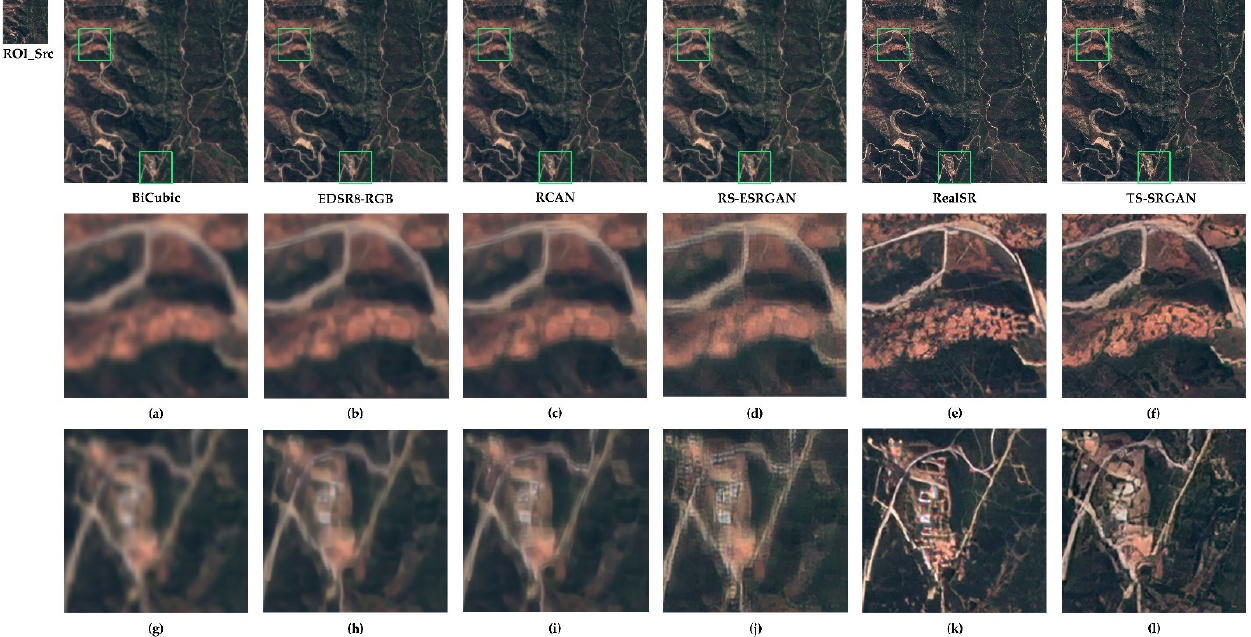
Figure 14. Comparison of visual effects of the generated images of the region containing mountain- road terrain. NR-IQA of images (NIQE, BRISQUE, PIQE): BiCubic (6.28, 54.73, 91.87), EDSR8-RGB (5.85, 50.25, 86.05), RCAN (4.64, 47.69, 62.20), RS-ESRGAN (3.31, 22.16, 8.42), RealSR (3.16, 15.75, 8.52), TS-SRGAN (2.43, 7.36, 7.48). The subfigures ( a – l ) in the figure represent an enlarged view of the local details in the green boxes in the generated image.